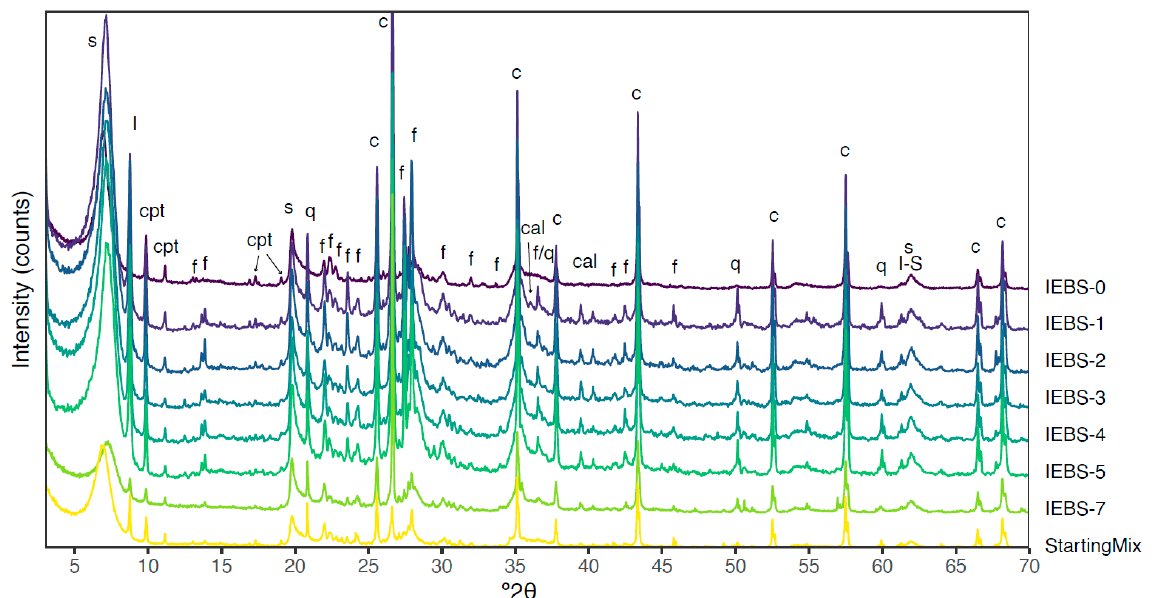
Figure 2. QXRD patterns of the Starting Mix of reactants (20% GG: 80% WB) and of the reacted mixture of solid phases from each experiment. Peaks identified and labelled include smectite (s), illite (I), clinoptilolite (cpt), feldspars (f), quartz (q), calcite (cal), mixed illite-smectite (I–S), and corundum (c, used as internal standard). Note that few differences in peaks are visually identifiable between different samples, illustrating the lack of substantive alteration of the mineral